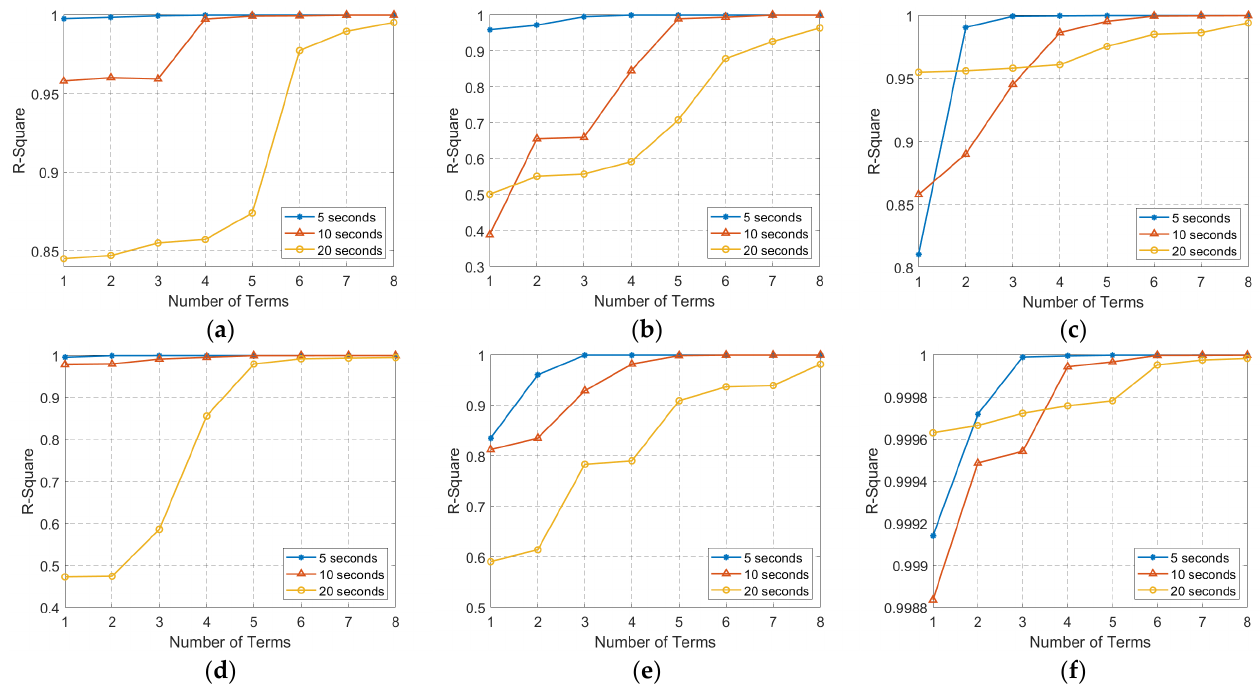
Figure 25. The fitting results of the measured ship attitude angles by using 1~8 terms of Fourier series. ( a – c ) Roll, pitch, heading angles in the unanchored state; ( d – f ) roll, pitch, heading angles in the navigating state. The abscissa of the graph is the number of the terms used for fitting, and the ordinate is the R-square (coefficient of determination), which indicates the fitting effect.